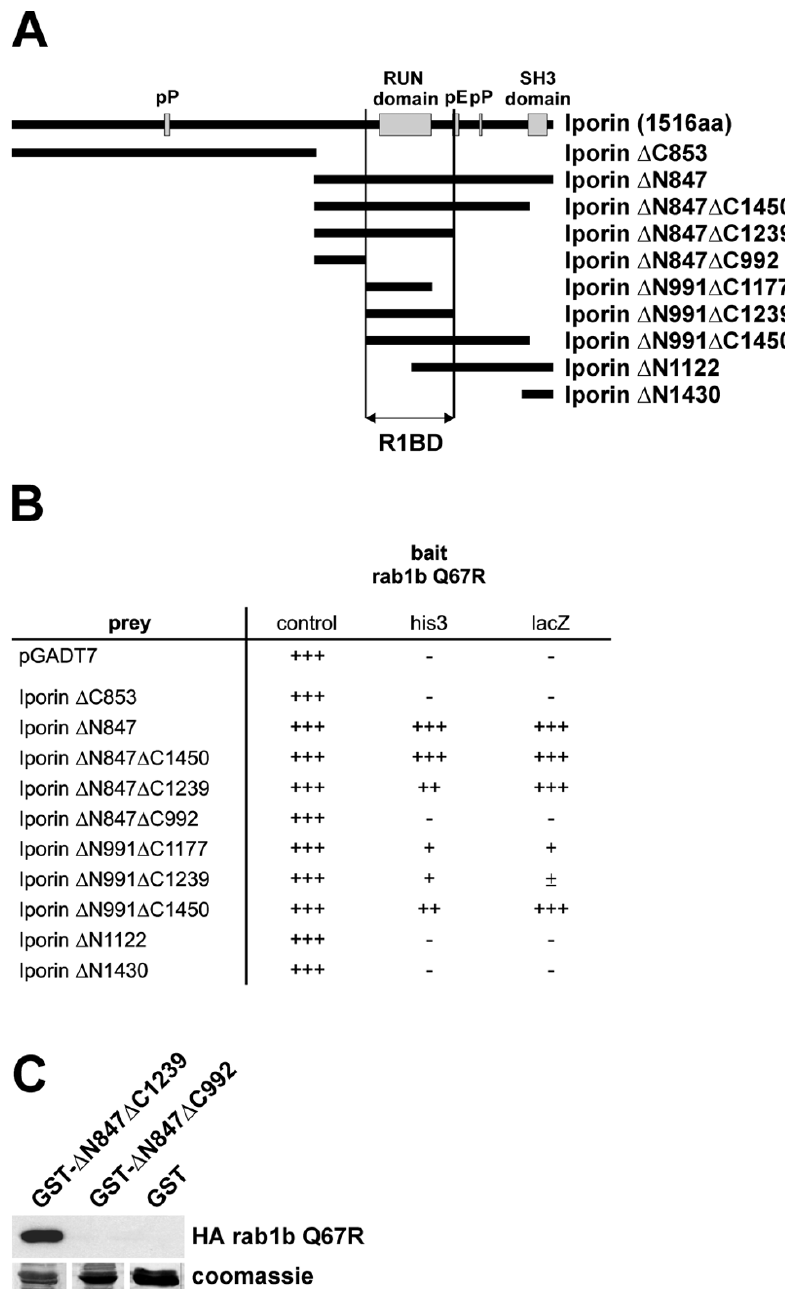
Figure 3 Mapping the rab1 binding domain (R1BD) of Iporin. (A) Overview of deletion mutants used for yeast co-transforma- tion assays. The deletion mutants ∆ Nx or ∆ Cx do not contain the N-terminus or the C-terminus, respectively. We were able to map the rab1 binding domain (R1BD) to a RUN domain containing region. (B) Results obtained from yeast co-transforma- tions. The bait construct rab1b Q67R was cloned into the pAS2-1 vector and the prey constructs into pGADT7. Clones were cultivated on selection plates as described previously (see Table 1). (C) GST-pulldown with coupled GST-Iporin ∆ N847 ∆ C1239 indicated an interaction with Iporin, whereas GST-Iporin ∆ N847 ∆ C992 and GST were negative. The lower panel shows the Coomassie blue stained blot membrane with equal amounts of GST fusion protein. - = no growth on selection plates or no β -galactosidase activity; +/- = β -galactosidase activity appears overnight; + = slow growth or β -galactosidase activ- ity appears after several hours; ++ = strong growth; +++ = very fast growth or high β -galactosidase activity; pP = polyproline; pE = polyglutamic